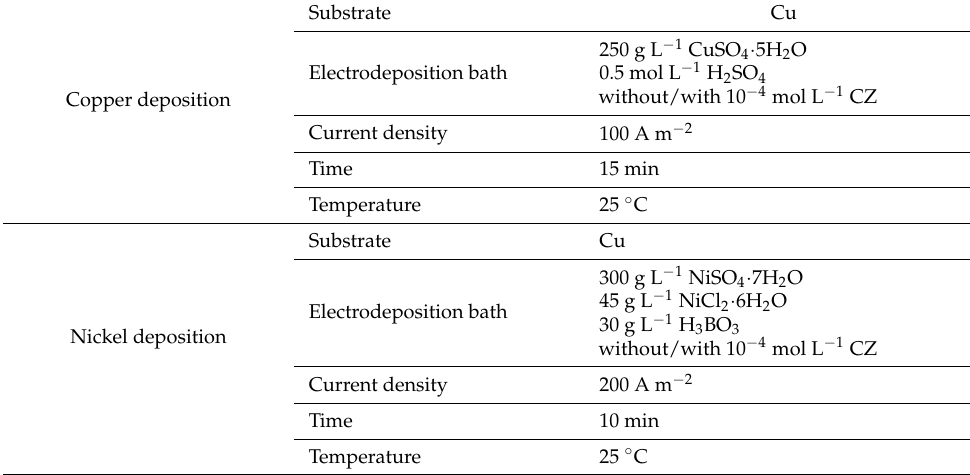
Table 5. Electrodeposition